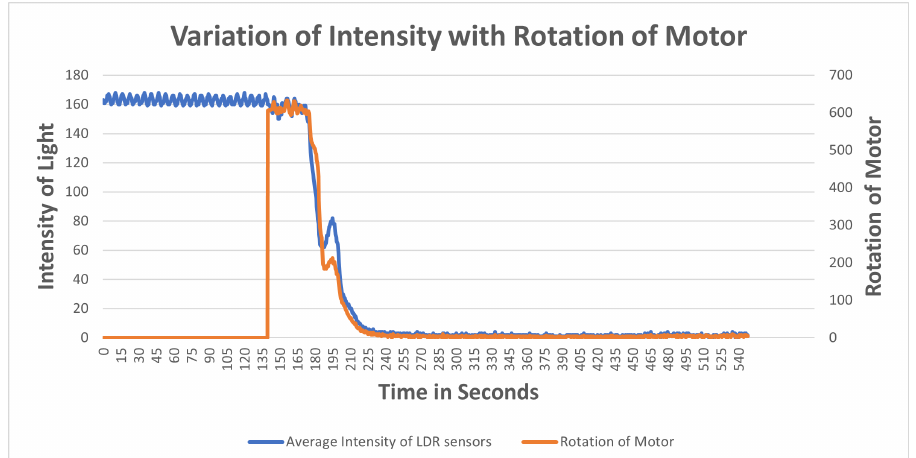
Figure 18. Variation of rotation of motor with the average intensity of light of bottom LDR sensors.